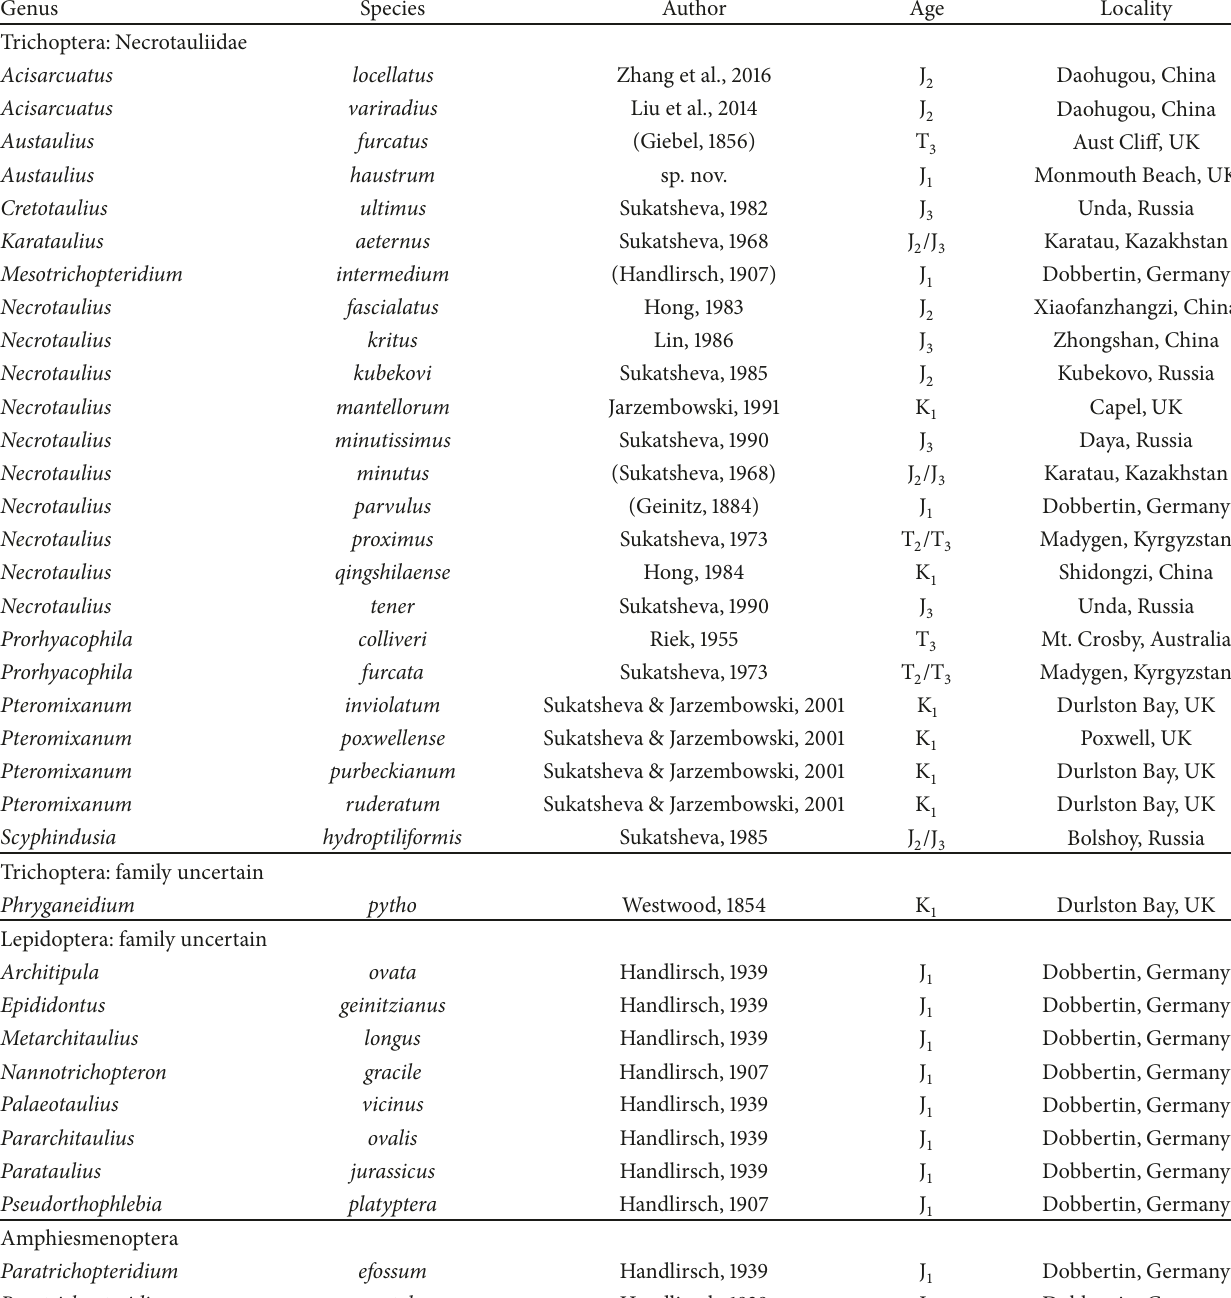
Table 1: Known species of Necrotauliidae and previous species now associated with the lepidopteran lineage. T 3 : Late Triassic; J 1 : Early Jurassic; J 2 : Middle Jurassic; J 3 : Late Jurassic; K 1 : Early